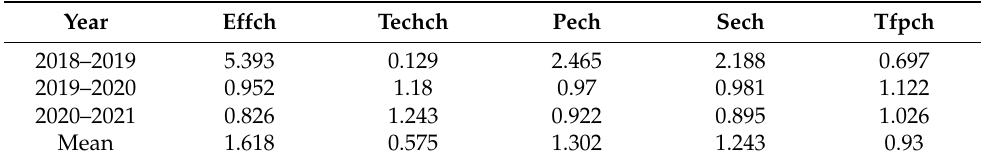
Table 7. Corporate Malmquist Index and its Decomposition